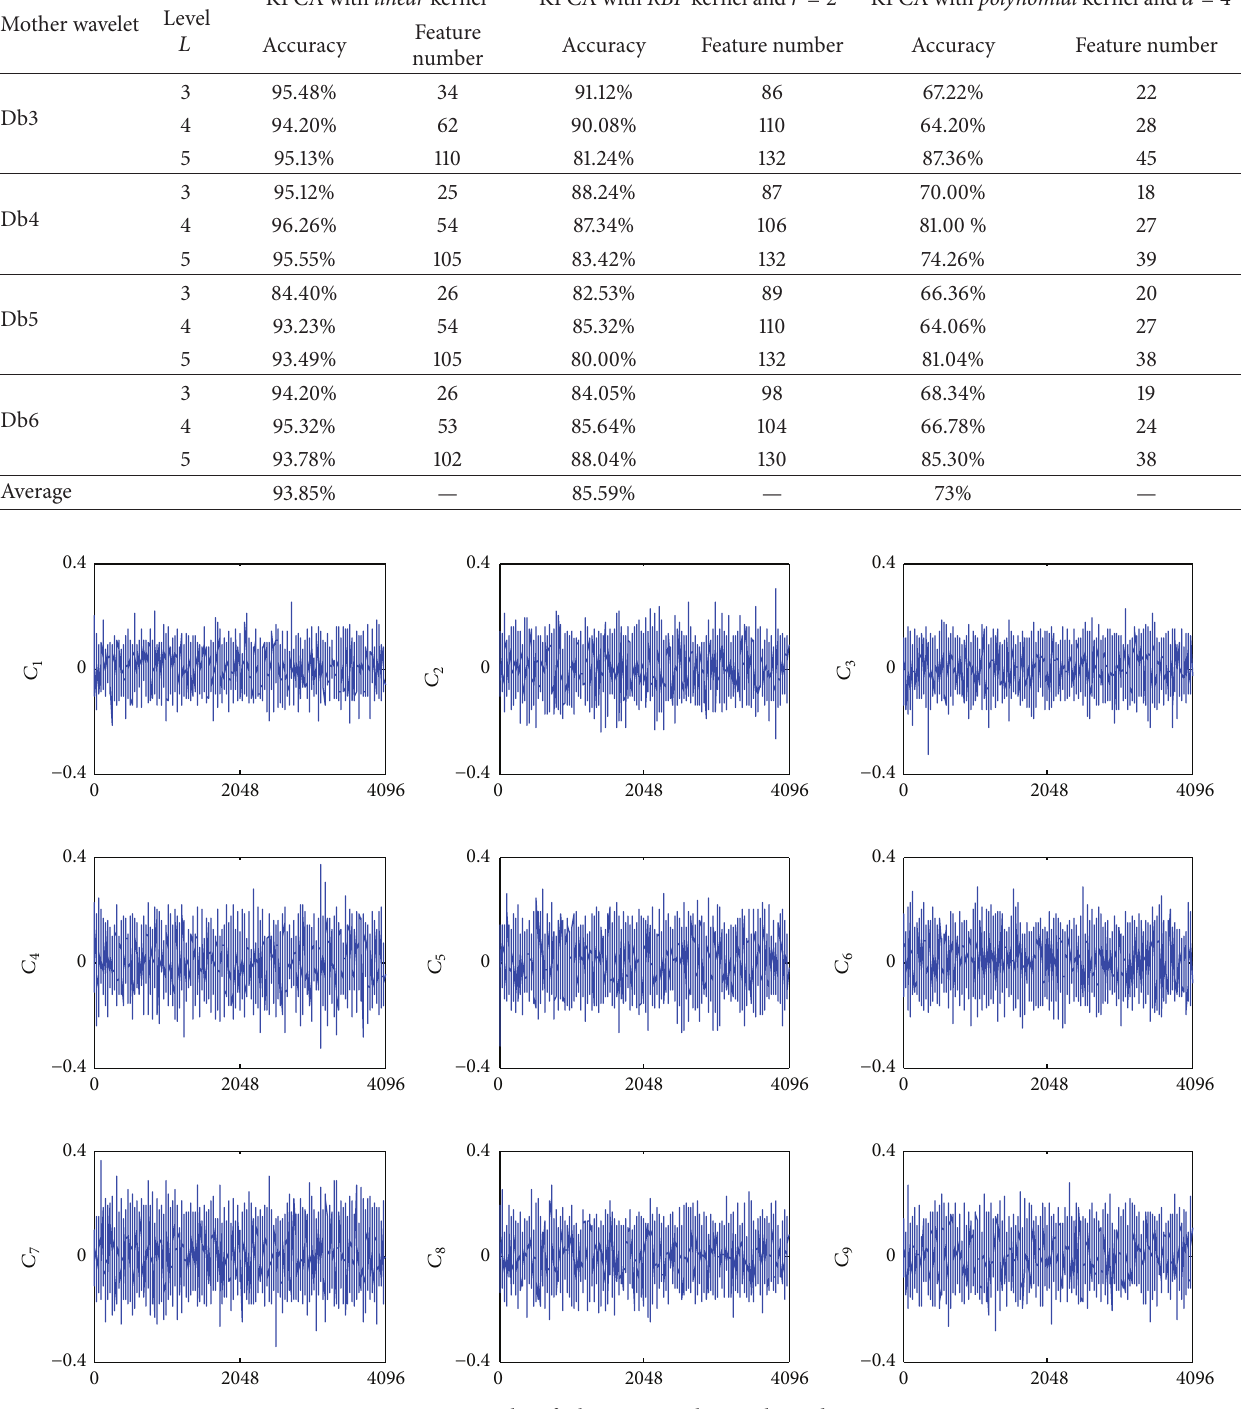
Table 5: Accuracies of SVM classifier under various kernels of KPCA and mother wavelets.